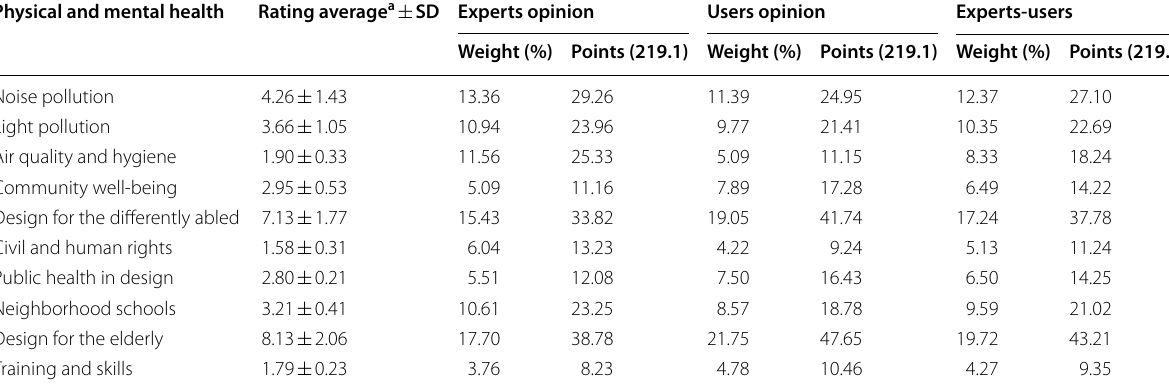
Table 5 Rating and weights of factors in the physical and mental health category